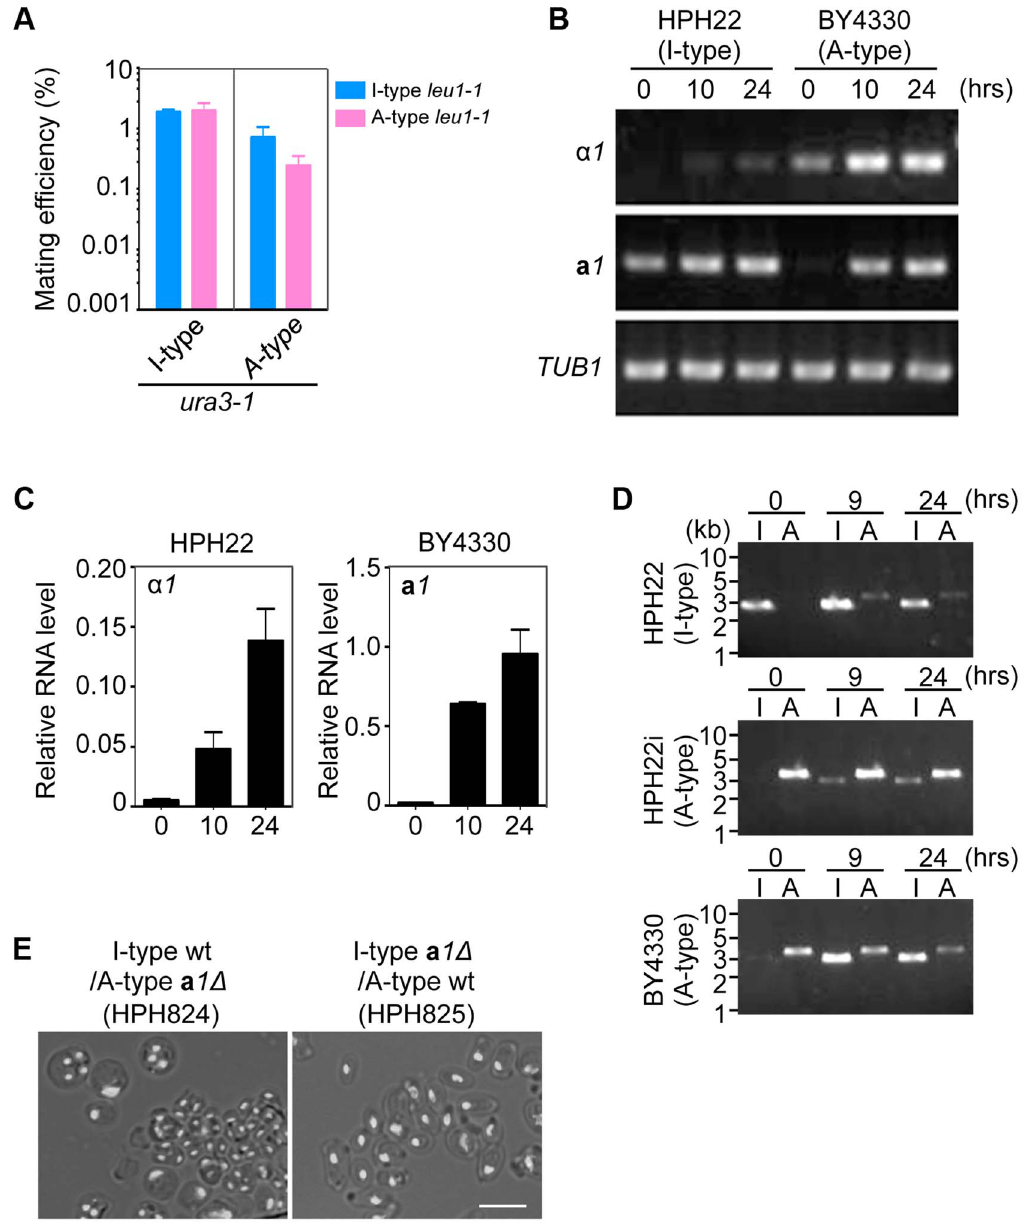
Figure 5. Inversion of the MAT intervening region is induced during mating. (A) Mating assay between I (HPH22 and HPH719)- and A (HPH22i and BY4330)-type strains. Cells were treated as described in Fig. 3A. Shown is the average of three independent matings. Error bars indicate SD. (B) RT-PCR analysis of a 1 and a 1 genes. RNA samples were prepared from I (HPH22)- or A (BY4330)-type wild-type cells incubated on MEMA medium for the indicated times. Primers used for PCR are listed in Table S2. (C) Quantitative digital PCR analysis of a 1 and a 1 genes. RNA samples in (B) were subjected to digital PCR analysis. a 1 and a 1 RNA levels were normalized to that of ACT1 RNA. Shown are the averages of two independent PCR reactions. Error bars indicate SD. (D) PCR amplification of the I- or A-type MAT1 locus. PCR reactions are as described in Fig. 4C. Genomic DNA samples were prepared from three wild-type strains (HPH22, HPH22i, and BY4330) after incubation on MEMA for the indicated times. The appearance of the I product in the reaction with BY4330 (A-type) after 9 and 24 h indicates a switch to the I-type in a subset of the population. (E) Meiosis in a 1 D / + heterozygous diploid cells. a 1 D (I-type) / + (A-type) is defective in meiosis. Cells were prepared as described in Fig. 4E. Shown are merged brightfield and DAPI epifluorescence images. Bar, 5 m